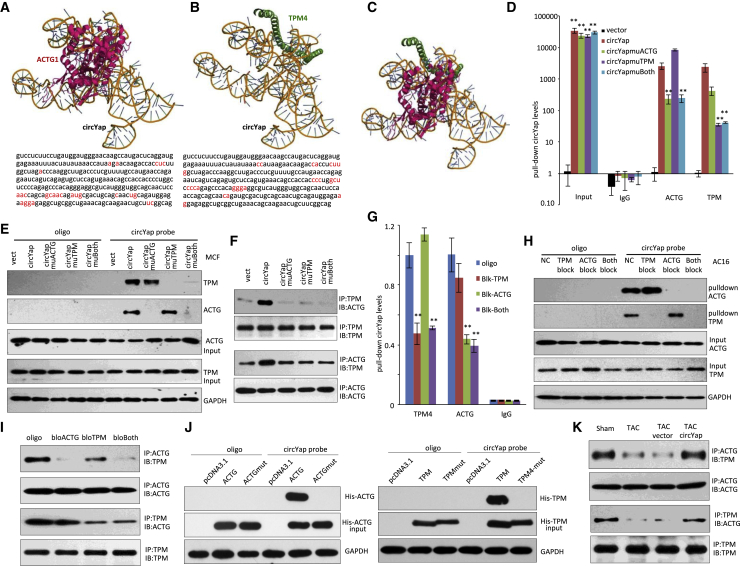
Identification of the Binding Sites of circYap with ACTG and TPM4(A and B) The binding sites of circYap with ACTG protein (A) and TPM4 protein (B) were identified via computational approach. (C) Docking of the circYap-TMP4-ACTG complex. (D) RNA-immunoprecipitation by antibodies against ACTG and TPM4 was performed in MCFs transfected with circYap or mutant constructs. Mutations decreased the antibodies precipitating circYap. n = 4. ∗∗p < 0.01. circYapmuACTG: ACTG binding site mutation in circYap; circYapmuTPM: TPM4 binding site mutation in circYap; circYapmuBoth: both ACTG and TPM4 binding sites mutation in circYap. (E) ACTG and TPM4 that bound with circYap were detected with respective antibodies after circYap was pulled down by its probe. ACTG and TPM4 proteins were pulled down by the circYap without binding sites mutation but not with binding sites mutation. circYapmuACTG, ACTG binding site mutation in circYap; circYapmuTPM, TPM4 binding site mutation in circYap; circYapmuBoth, both ACTG and TPM4 binding sites mutation in circYap. n = 3. (F) Antibody against ACTG could precipitate TPM4 and vice versa with circYap overexpression. Binding sites mutation of circYap decreased the interactions of ACTG with TPM4. n = 3. (G) RNA-immunoprecipitation of circYap by antibodies against ACTG and TPM4 was performed in AC16 cells transfected with blocking oligos that reverse complement to the ACTG or TPM4 binding sites. n = 4. ∗∗p < 0.01. (H) ACTG and TPM4 were pulled down by the circYap in AC16 cells transfected with the blocking oligos. The blocking oligos inhibited circYap pulling down the ACTG and/or TPM4 proteins. n = 3. (I) Transfection with the blocking oligos inhibited ACTG precipitating TPM4 and vice versa. n = 3. (J) Plasmids that could be translated to His-tagged ACTG and TPM4 protein with or without circYap binding site mutation (ACTGmut and TPM4mut) were transfected to circYap-overexpressed MCF cells. The circYap could not pull down ACTG or TPM4 with the binding site mutation. n = 3. (K) In the heart tissue of TAC mice, decreased expression of circYap inhibited ACTG precipitating TPM4 and vice versa. Ectopic delivery of circYap plasmids increased the interaction of ACTG and TPM4. n = 3.